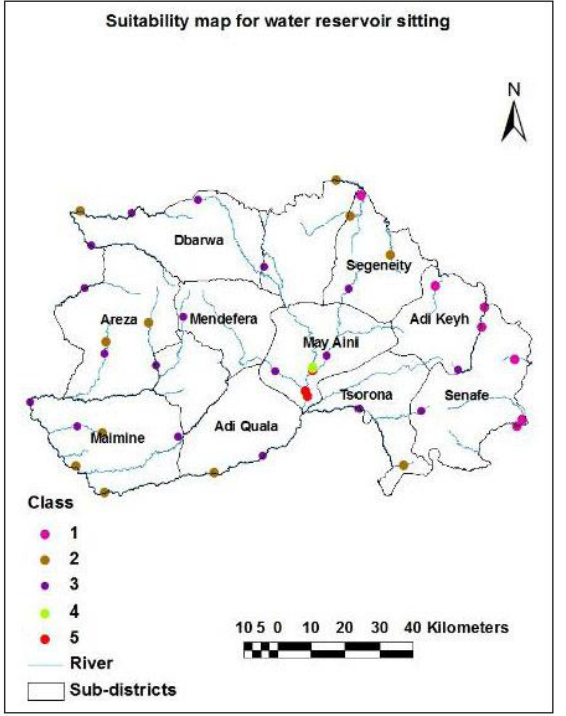
Figure 9. Candidate water reservoir sites in suitability